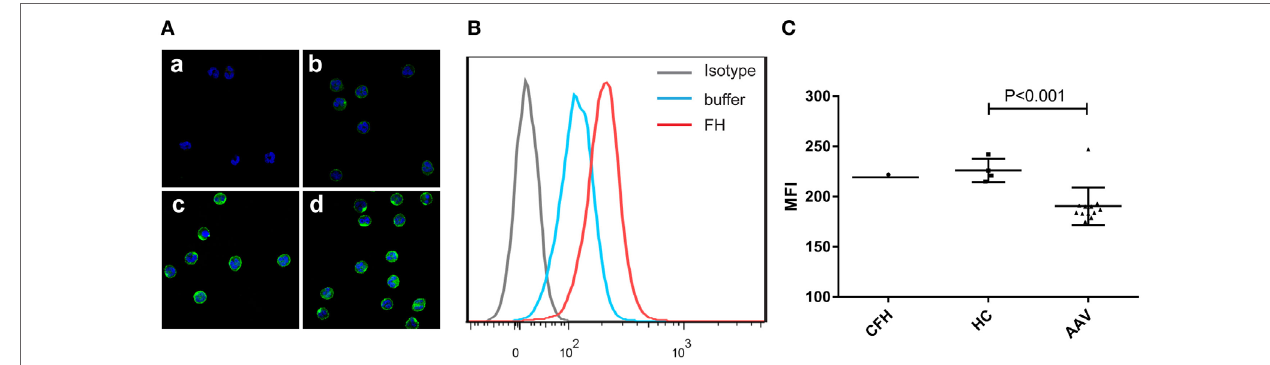
FigUre 1 | Binding of factor H (FH) to human neutrophils. Neutrophils were incubated with FH or buffer, and bound FH was detected using goat anti-human FH antibody. Normal goat IgG was using as the relevant isotype control antibody. (a) Representative confocal images show binding of FH to the cell surface of neutrophils. [ (a) , a] Isotype control; [ (a) , b] negative control performed by incubating neutrophils with buffer only; [ (a) , c,d] neutrophils were incubation with FH followed by detection using goat anti-human FH antibody. (B) Shown is a representative histogram out of three independent experiments performed by flow cytometry. (c) Flow cytometry analysis of binding of FH to neutrophils. FH purified from healthy controls exhibited similar binding activity to commercial FH, while FH from patients with active ANCA-associated vasculitis bound less efficiently to